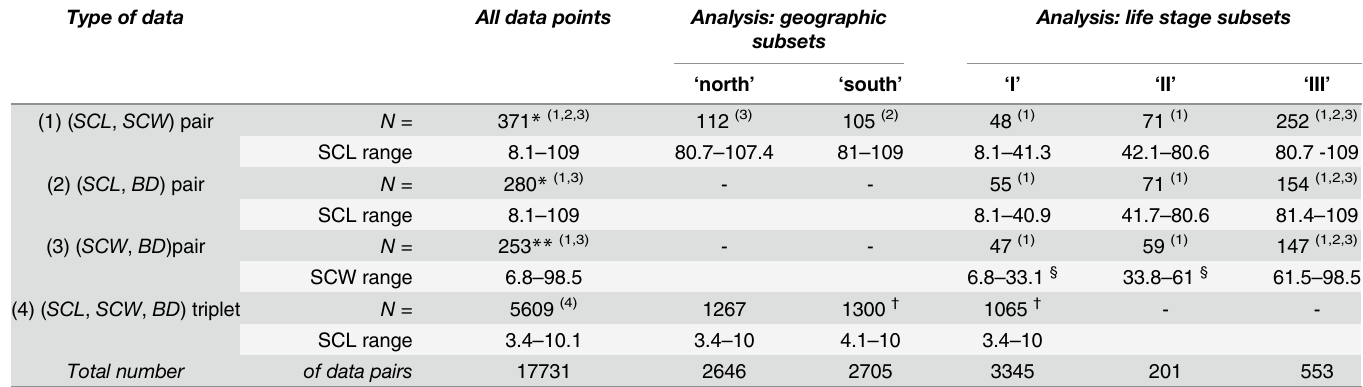
Table 1. Data overview. We studied straight carapace length (SCL), straight carapace width (SCW), and body depth (BD). We used ( SCL , SCW ), ( SCL , BD ), and ( SCW , BD ) data pairs for the analysis, meaning that one data triplet yielded 3 data pairs. See text for details. Life stage subsets: ‘ I ’— posthatchlings and oceanic juveniles, ‘ II ’— neritic juveniles, and ‘ III ’— nesting adults. Range of SCL and SCW values is expressed in